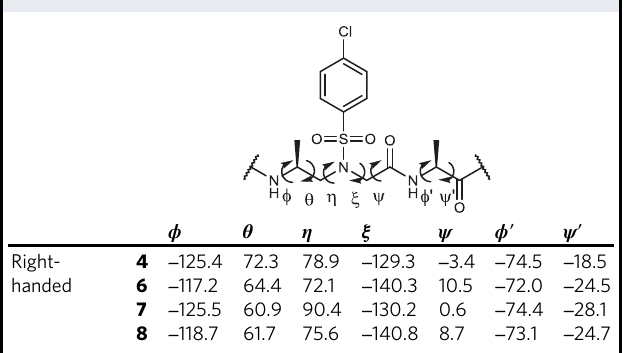
Table 2 Typical torsion angles (°) in foldamers 4, 6, 7, and 8 based on single